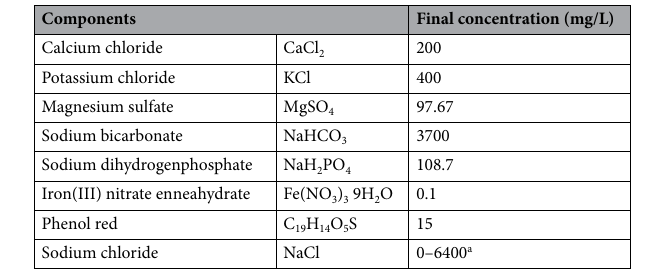
Table 1. Compositions of inorganic salt solution (ISS). a The sodium chloride concentration was modified by the final osmolality of the